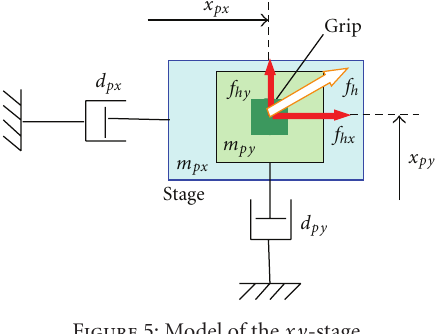
Figure 5: Model of the xy -stage. Table 1: Parameters and variables of haptic interface device.